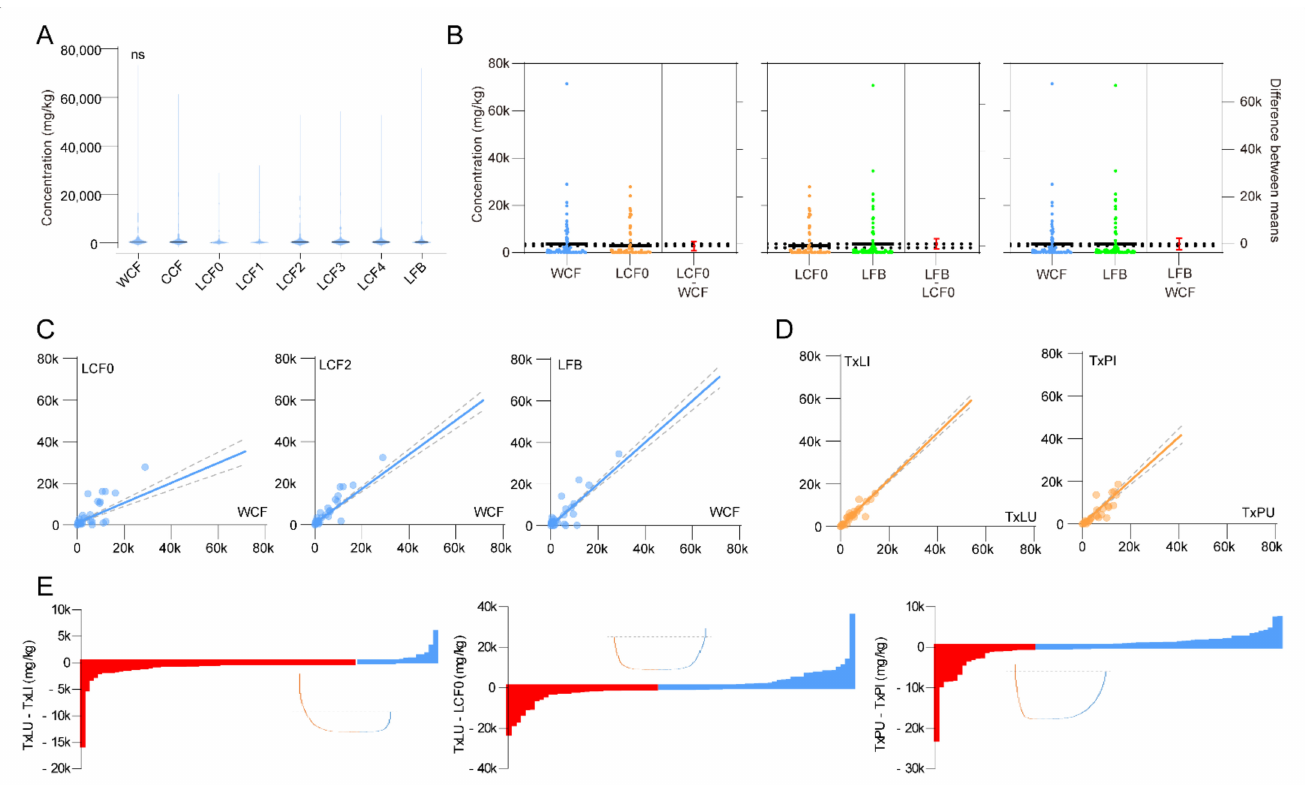
Figure 3. Stage, spatial and infection effectiveness on metabolites. ( A ) Overall comparison of metabolites among WCF, CCF, LCF0~4 and LFB. ( ANOVA , F 7, 776 = 0.386, p = 0.91) ( B ) Estimation plots using t tests between selected samples. Color indicates sample category. Error bars indicate S.E.M. No significant difference was observed in 3 tested pairs. (Students’ t test, LCF0-WCF: t 194 = 0.79, p = 0.43; LCF0-LFB: t 194 = 0.79, p = 0.43; LFB-WCF: t 194 = 0.03, p = 0.97) ( C ) Linear regression between selected samples for development effectiveness. Dotted lines indicate 95% C. I. Significant regression was found in all pairs. (Linear regression, LCF0-WCF: F 1, 96 = 109.0, r 2 = 0.53, p < 0.0001; LCF2-WCF: F 1, 96 = 553.7, r 2 = 0.85, p < 0.0001; LCF2-WCF: F 1, 96 = 669.0, LFB: r 2 = 0.87, p < 0.0001) ( D ) Linear regression between selected samples for infection effectiveness. Dotted lines indicate 95% C. I. Significant regression was found in all pairs. (Linear regression, TxLI-TxLU: F 1, 96 = 1799, r 2 = 0.95, p < 0.0001; TxPI-TxPU: F 1, 96 = 340.4, r 2 = 0.78, p < 0.0001) ( E ) Comparison of each metabolite among selected samples for assessment of infection effectiveness. Waterfall plots were developed using minus of selected sample pairs. Red bars indicate up-regulated metabolites, and blue bars indicate down-regulated